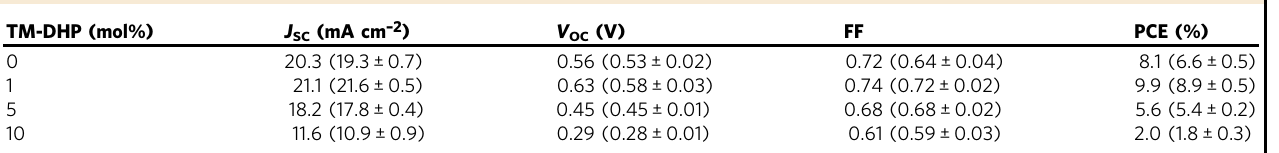
Table 1 Photovoltaic parameters of Sn-based PSCs with 0, 1, 5, and 10 mol% of TM-DHP. TM-DHP (mol%)